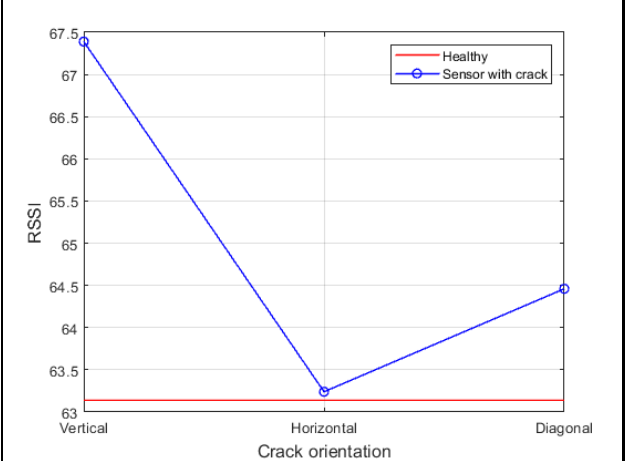
Figure 10. Cracked Tag response.